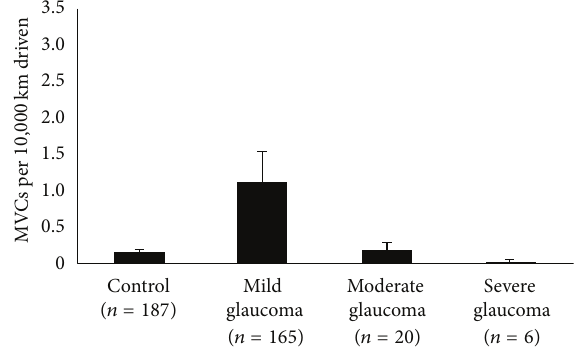
Figure 3: The association between the number of MVCs per 10,000 km driven and glaucoma severity, grouped by IVF. No significant association was observed between the accident rate and glaucoma severity, grouped by IVF ( 𝑃 = 0.12 , Jonckheere-Terpstra test). MVC (motor vehicle collision); IVF (integrated visual field). Error bar: standard